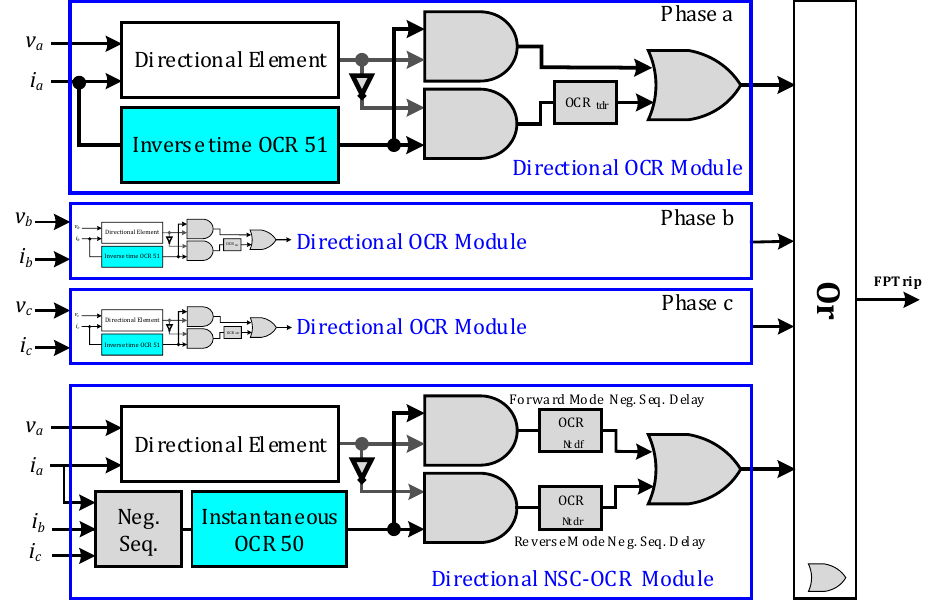
Figure 2. The proposed Feeder protection